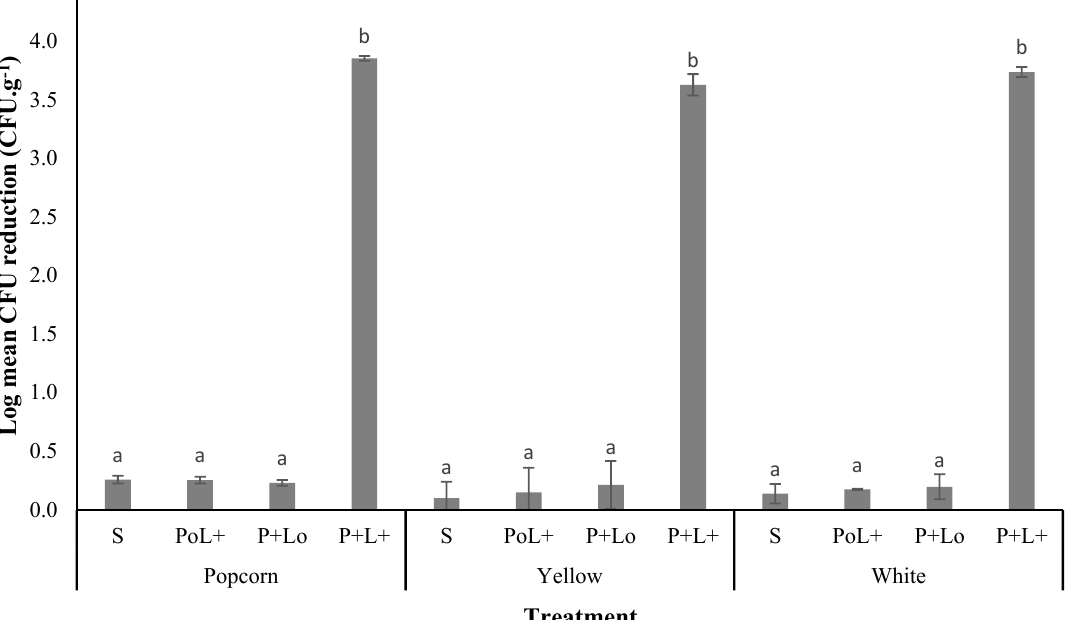
Figure 5. Photodecontamination of Aspergillus flavus spores on three maize varieties (popcorn, yellow and white). S = solvent (propylene glycol); P o L + = light; P + L o = photosensitizer; P + L + = photosensitization. Data are means ± SE ( n = 3); means with different letters in the same column are significantly different ( p < 0.05).